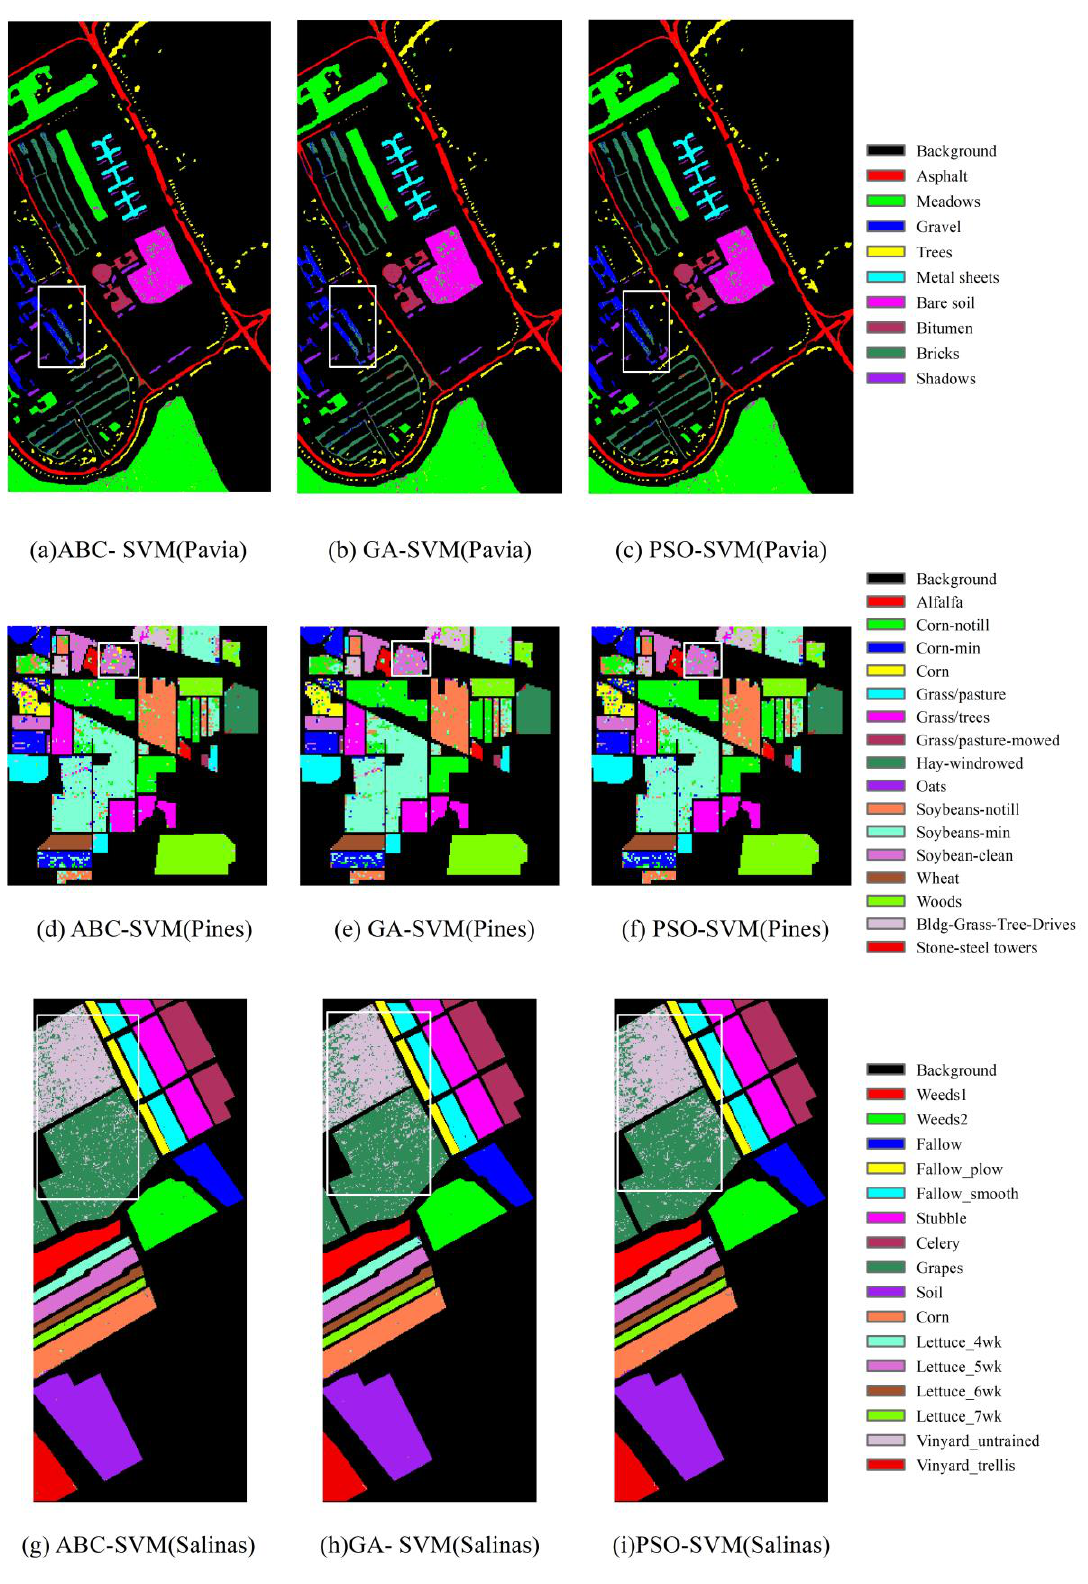
Figure 6. Classification maps of the Pavia University ( a – c ), Indian Pines ( d – f ), and Salinas ( g – i ) images.